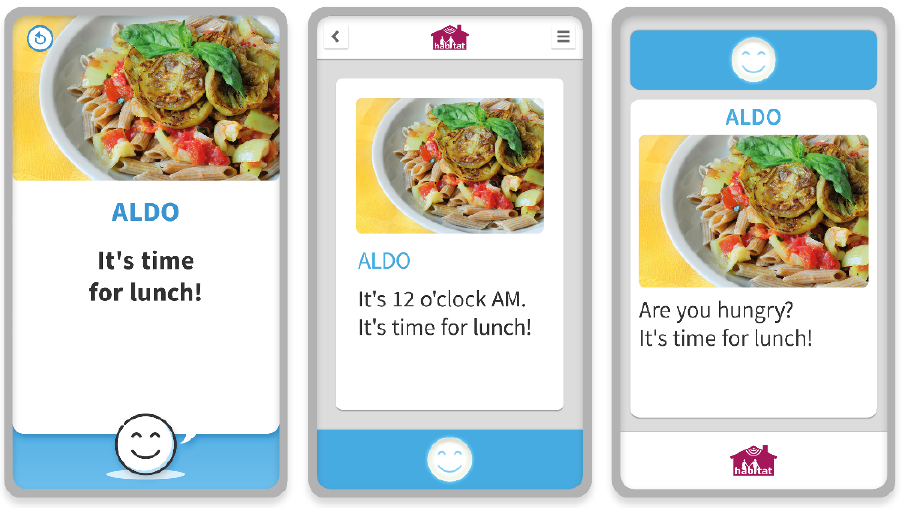
Figure 9. Representation of HABITAT’s interface evolution based on the aspects delineated in the two co-design workshops.